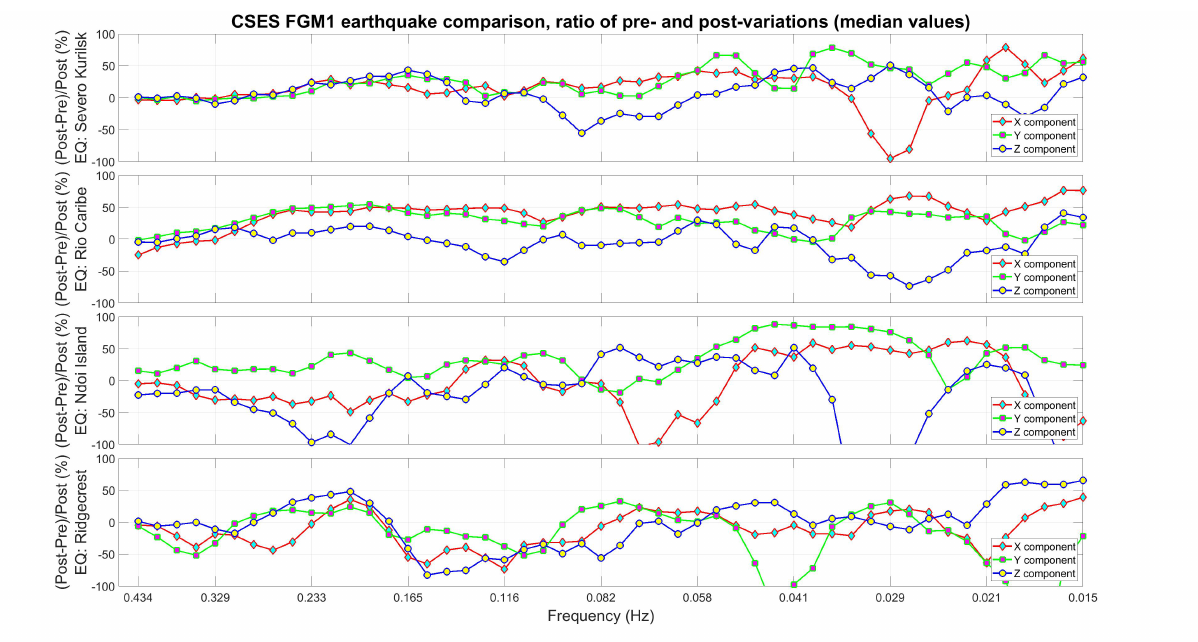
Figure 11. Relative changes based on median values of pre- and post-variations for the earthquakes M6.5 Severo-Kurilsk, M7.3 Rio Caribe, M8.2 Ndoi Island, and M7.1 Ridgecrest from CSES FGM1 magnetic field measurements. For Severo-Kurilsk (Figure 3), Rio Caribe (Figure 4), and Ridgecrest (Figure 6) the applicable range is from 0.434 Hz to 0.041 Hz, for Ndoi Island (Figure 5) up to 0.082 Hz, frequency bands below have too weak fluctuations. After an increase in the ratios to positive values, Severo-Kurilsk and Rio Caribe show enhancements mainly in the X- and Y-components along the frequency band, Ndoi Island is higher in the Y-component with oscillating behaviour. Ridgecrest shows a sinusoidal modulation of the ratios from higher to lower frequencies. For all events usually at least two (varying) components have a parallel moving